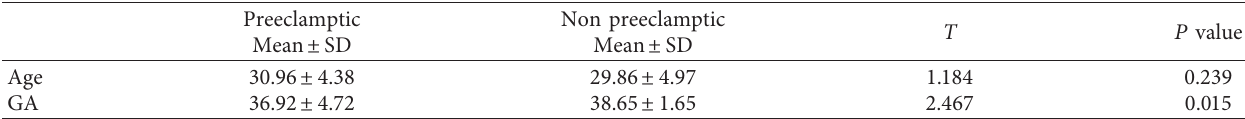
Figure 1: Flow pattern of serum uric acid level and pregnancy outcome among preeclamptic normal pregnant women. SCBU � special care baby unit. Table 1: Mean maternal age and gestational age of subjects.